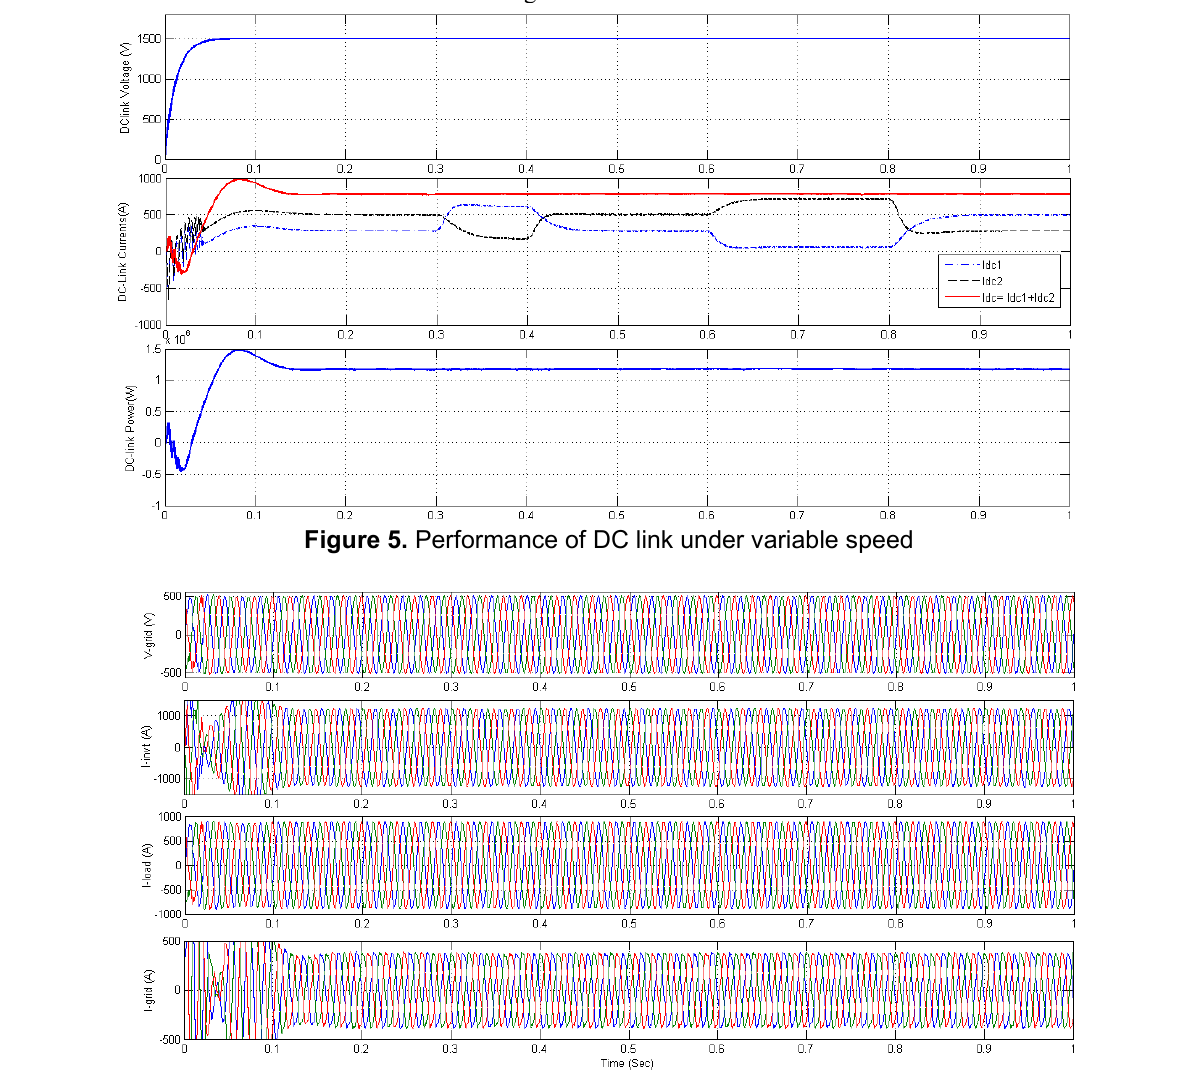
Figure 6a. Grid performance when